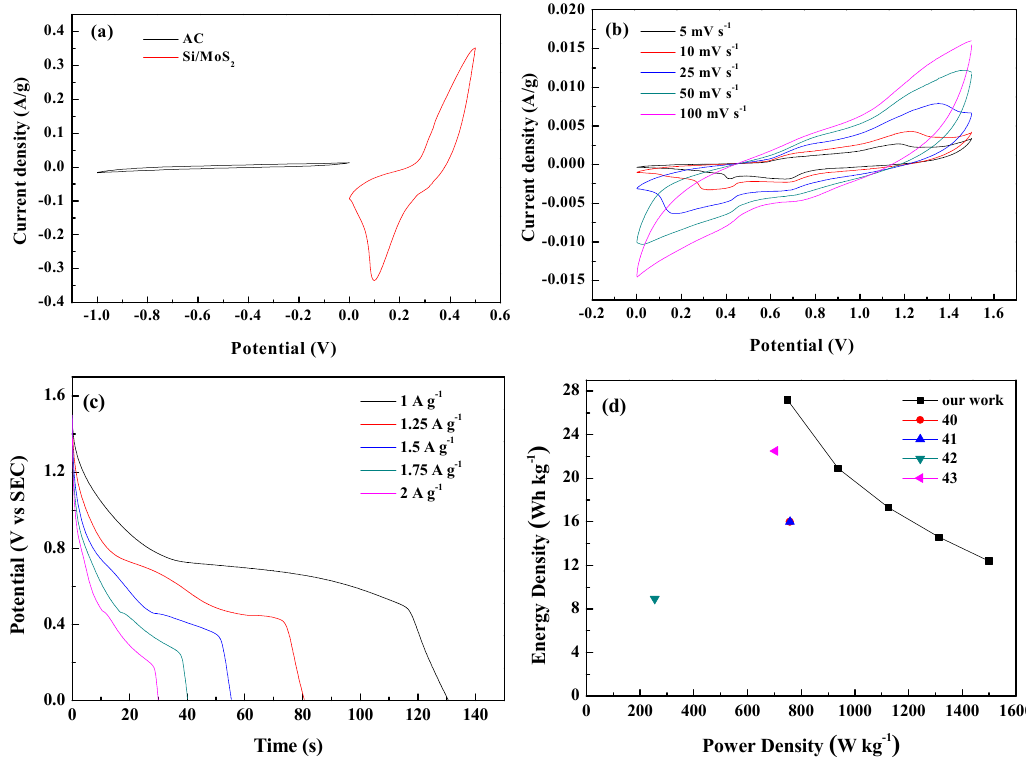
Figure 7. ( a ) CV curve of AC and Si/MoS 2 composite, separately tested in three-electrode system at 100 mV·s − 1 ; ( b ) CV curve of asymmetric supercapacitor (Si/MoS 2 //AC); ( c ) GCD curve of Si/MoS 2 //AC; 100 mV · s − 1 ; ( b ) CV curve of asymmetric supercapacitor (Si / MoS 2 // AC); ( c ) GCD curve of Si / MoS 2 // AC; ( d ) Ragone plots of Si / MoS 2 // ( d ) Ragone plots of Si/MoS 2 //AC.